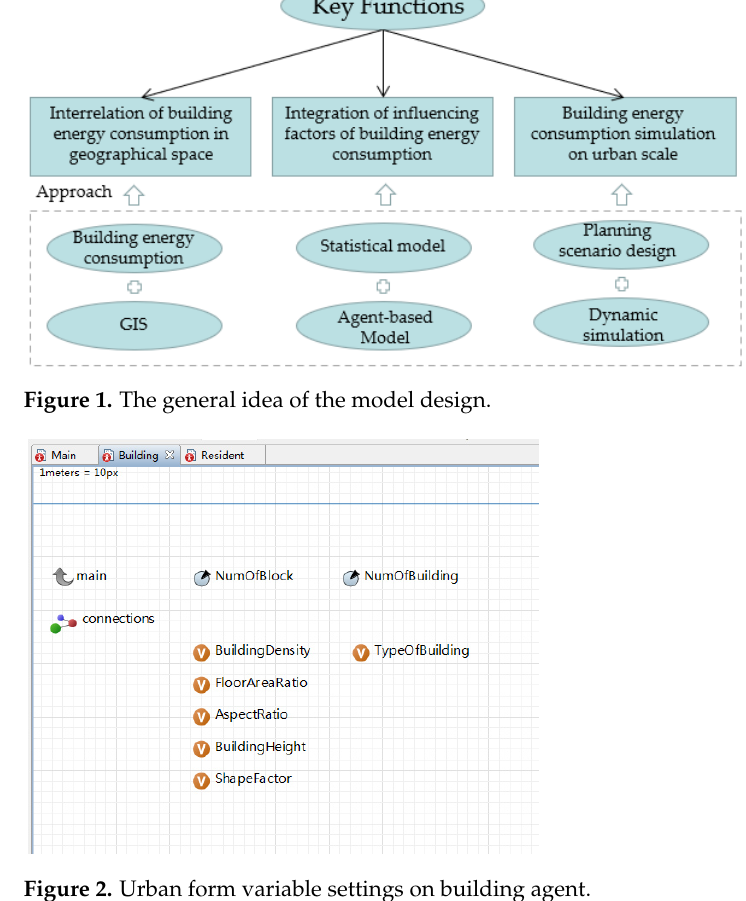
Figure 2. Urban form variable settings on building agent.